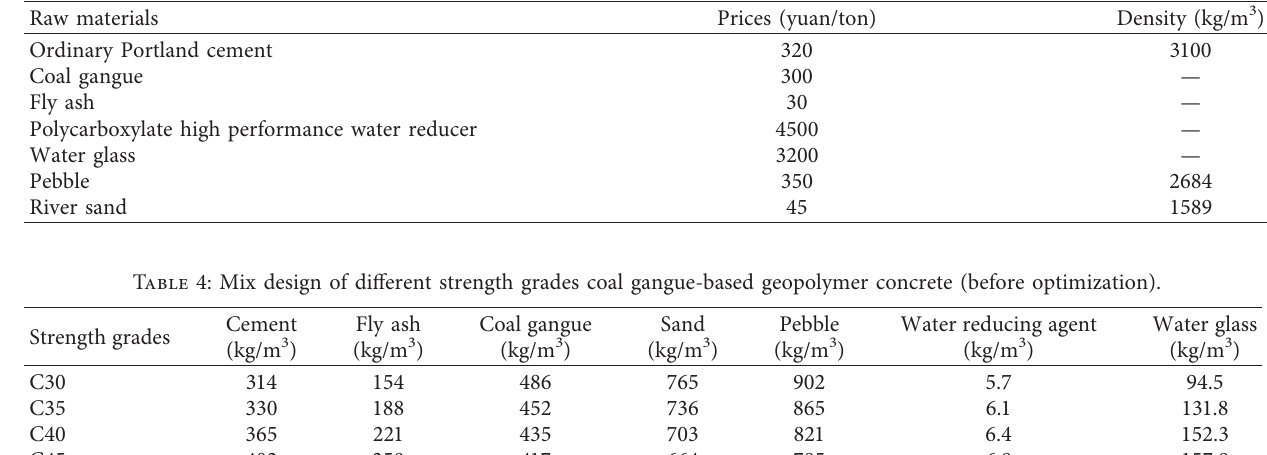
Table 3: The market prices of raw materials (yuan/ton).